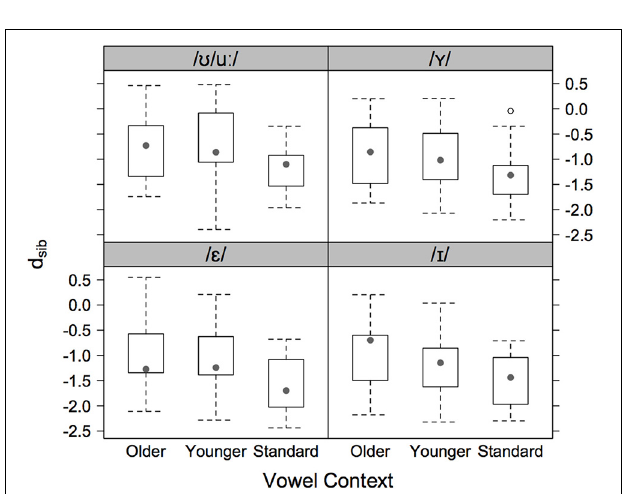
(cid:2) FIGURE 2 | Boxplots of the log. Euclidean distance ratio, d sib for sibilants in /st/-clusters to the /s/ and / /-centroids (older AG left, younger AG center, and SG right) and vowel context (/ ε / bottom left, / I / bottom right, / Y / top (cid:2) right, / (cid:2) / top left). Negative values indicate productions closer to the /s/-centroid, positive values are productions closer to the /